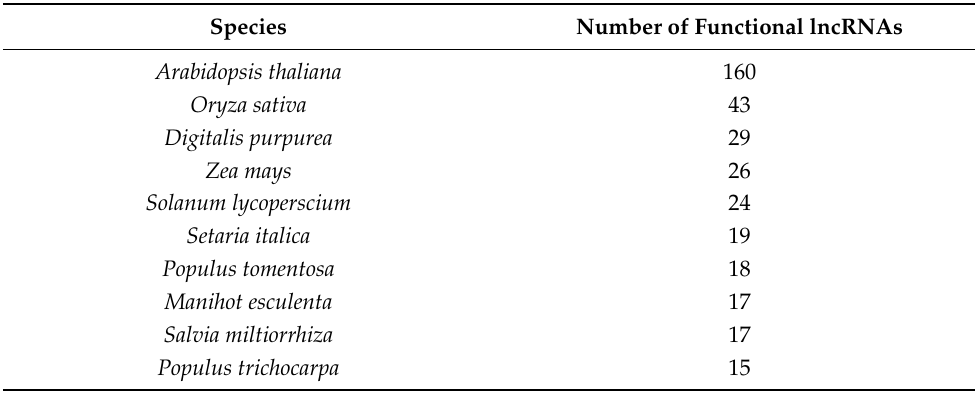
Table 1. Validated long non-coding RNAs in 10 plant species [6].